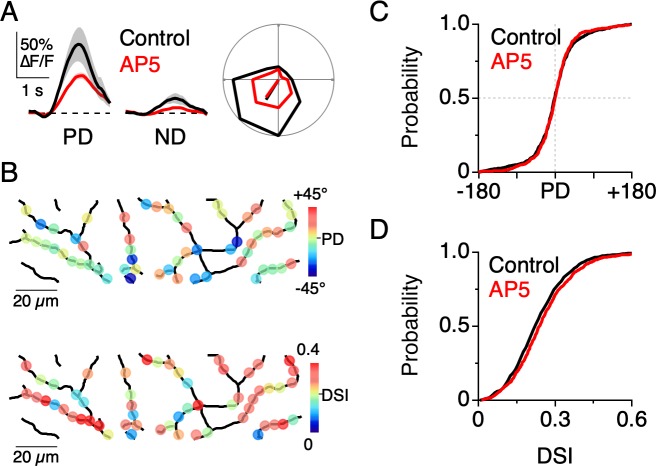
NMDA receptors amplify dendritic responses without altering direction selectivity.(A) Example Ca2+ signals in response to preferred and null motion in control conditions (black) and in the presence of the NMDA receptor antagonist, D-AP5 (50 µM; red). Shading is ± s.e.m. Right, Example polar plot showing the directional tuning of dendritic Ca2+ signals before and after NMDA receptor blockade. (B) Map of the PD (top) and DSI (bottom) for dendritic ROIs during NMDA receptor blockade. (C) Cumulative distributions of the PD for dendritic ROIs. (D) Cumulative distributions of the DSI for dendritic ROIs.Figure 6—source data 1.Calcium responses, and dendritic tuning distributions.